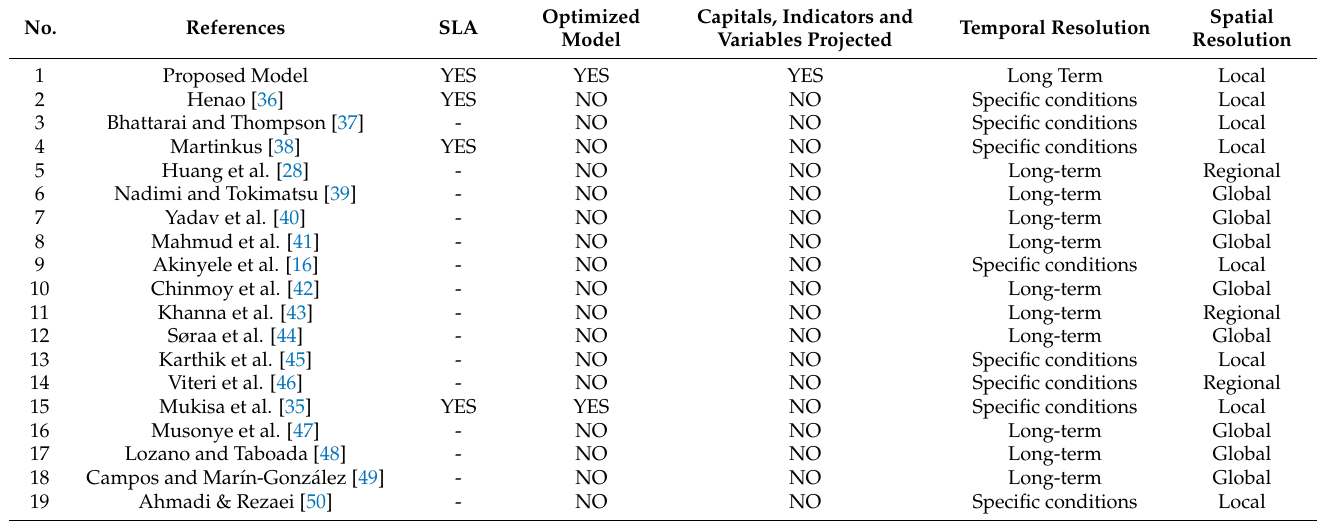
Table 5. Proposed model